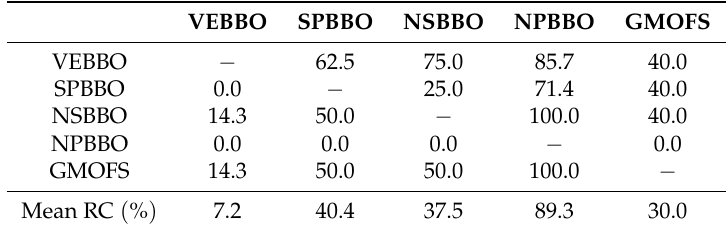
Table 5. Comparison of Pareto fronts using normalized hypervolume. N p is the number of Pareto points obtained by each MOO method. VEBBO and GMOFS rank first and second, respectively, in terms of normalized hypervolume, and GMOFS ranks first in terms of the number of points. N